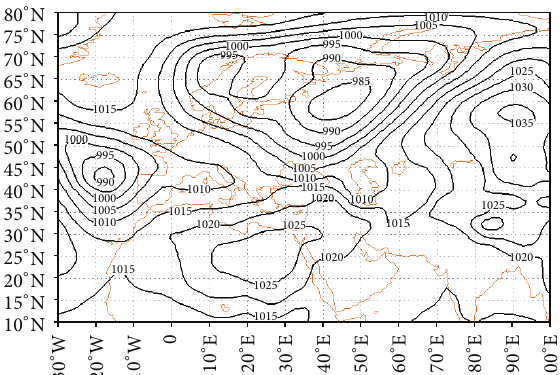
Figure 11: Sea level pressure map.